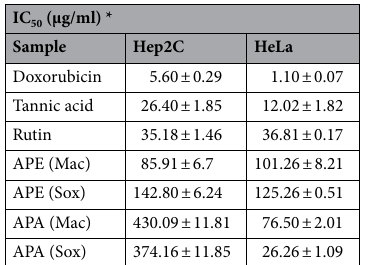
Table 3. In-vitro the antiproliferative activity (IC 50 ) of extracts of A. precatorius seeds after 48 h of treatment. *Values are means of three replicate samples (n = 3). Data are presented as the mean ±